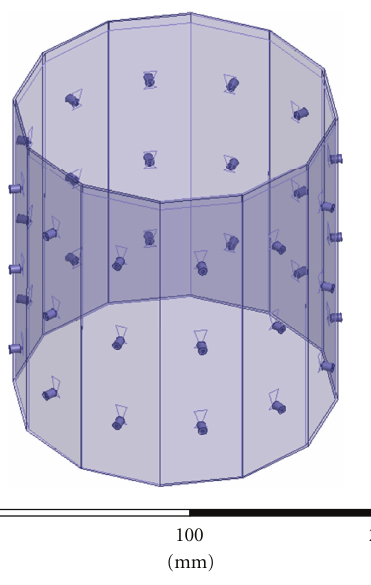
Figure 4: HFSS CAD model of the imaging cavity. Twelve panels contain three bow-tie antennas each. The bottom of the cavity is PEC, it is filled with the coupling fluid up to the visible line, and the top surface radiates to